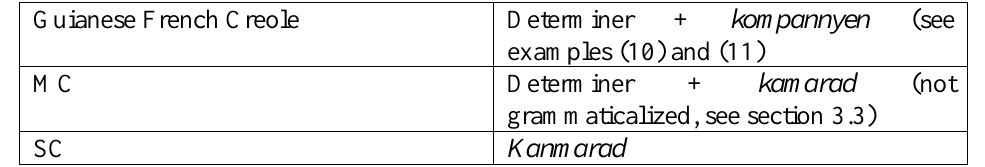
Table 2. Reciprocal constructions based on ‘companion’ in French creoles,